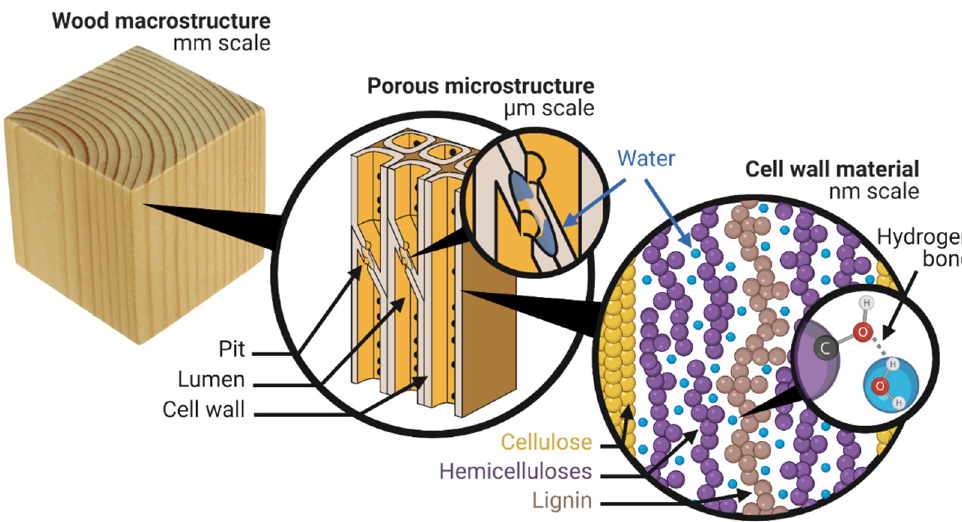
Figure 1. Water in different locations in wood. Cell wall water is found inside the solid cell walls where it interacts with the hydroxyls of the constituent polymers (cellulose, hemicelluloses, lignin) by hydrogen bonds. Capillary water is found in the porous microstructure of wood, e.g., in pits and lumina.